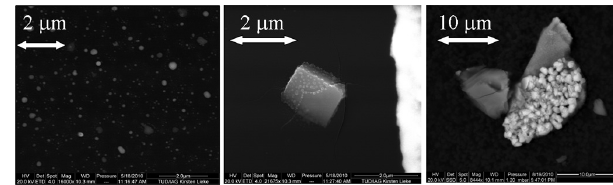
Fig. 5. Examples of ammonium sulfate particles (left), a silicate particle with droplets of ammonium sulfate (middle) and an ag- glomerate of large silicate particles with iron oxide (small particles; right) from the sample of 2